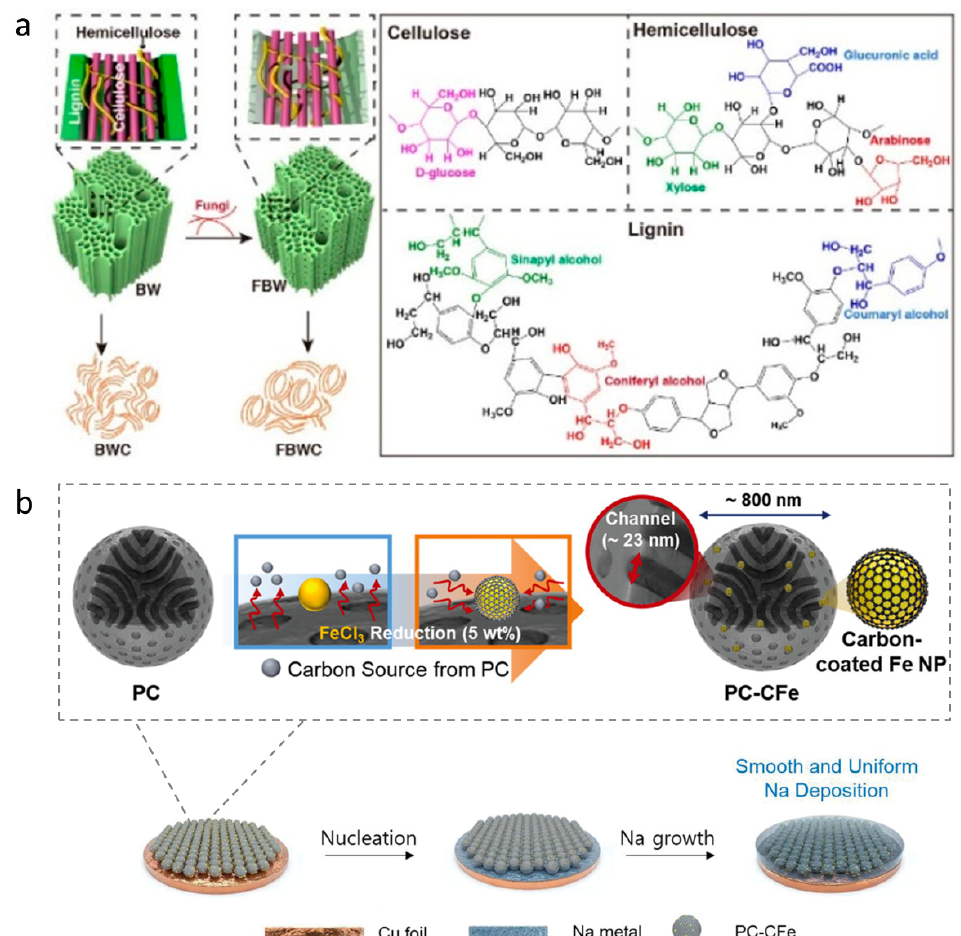
Figure 7. Schematic illustration of the fabrication processes of the ( a ) 3D carbon current collector [74]; copyright 2021 American Chemical Society; ( b ) 3D nanostructured porous carbon particle containing carbon–shell-coated Fe nanoparticles (PC–CFe) and the following nucleation and Na growth process [76]. Reproduced with the permission of ref. [77], copyright 2022 Wiley–VCH Verlag GmbH & Co. KGaA, Weinheim.